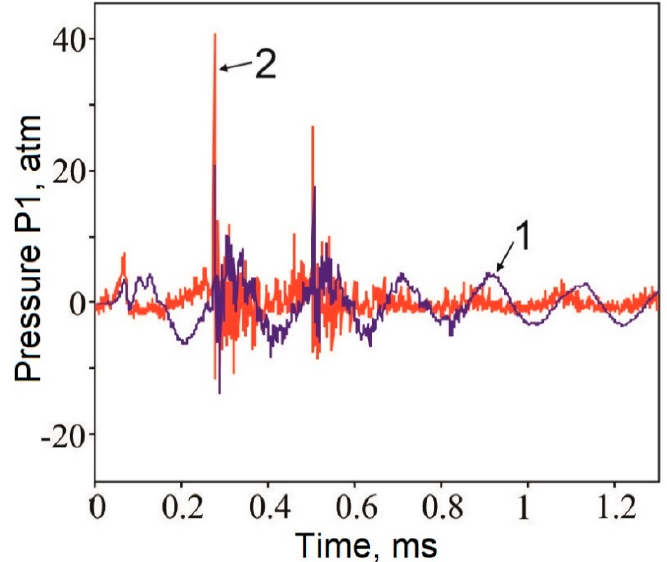
Figure 4. Fragments of typical acoustic signals registered by a wide-band hydrophone (1) and needle hydrophone (2) registered during the fragmentation of the stone phantom in the dusting regime. The pressure was recalculated for the distance of 100 µm.